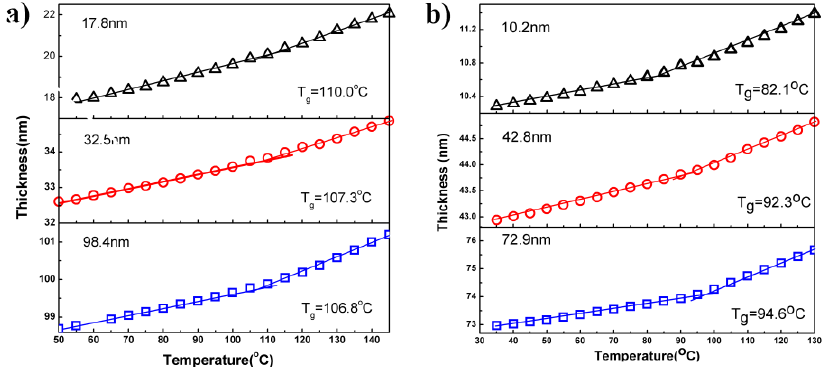
Figure 1. T g s of ( a ) poly(methyl methacrylate) (PMMA) and ( b ) PS thin films on the Si substrate determined by ellipsometery.